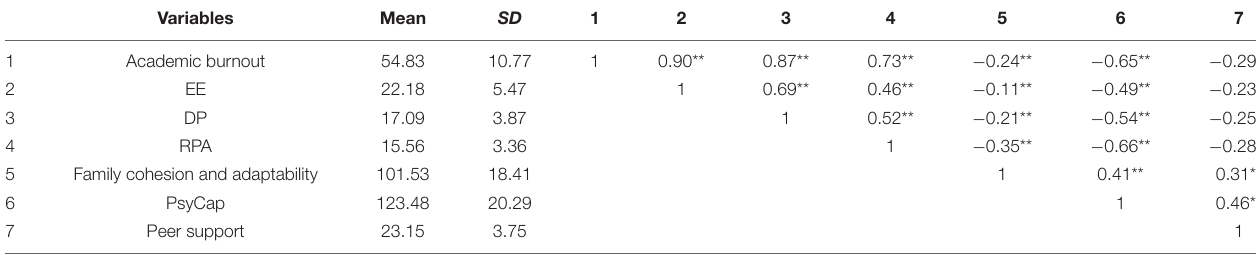
TABLE 2 | Means, SDs, and correlations between variables.